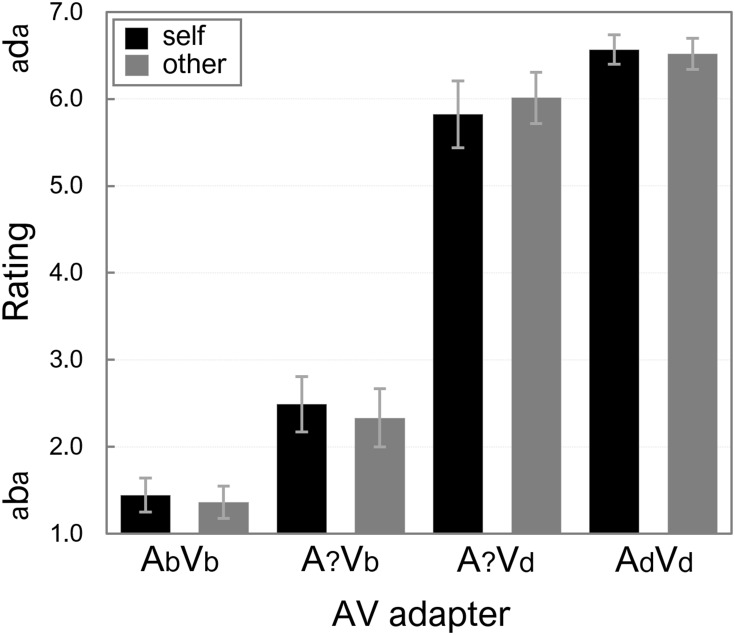
Mean ratings of the AV exposure stimuli for “self” and “other.” More “d-like” ratings are reflected by higher numbers on the y-axis. Error bars represent standard errors of the means.